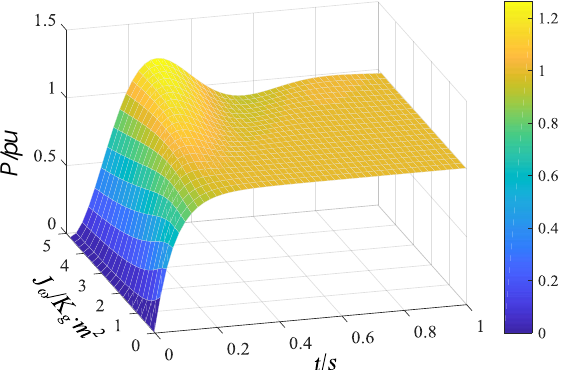
Figure 3. Step response of Gr ( s ) with J ω varies.